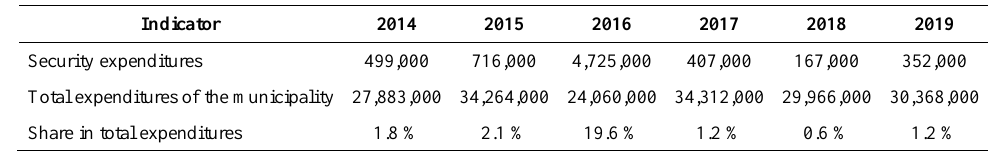
Table 4. Trends in the expenditures of the Security and Legal Protection budget group in the municipality Vlachovice